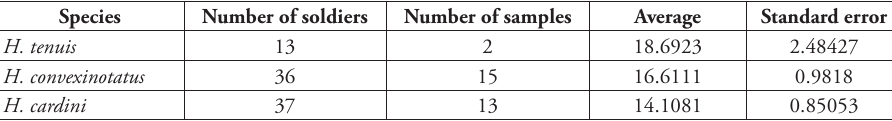
Table 3. Summary statistics for cephalic seta counts.